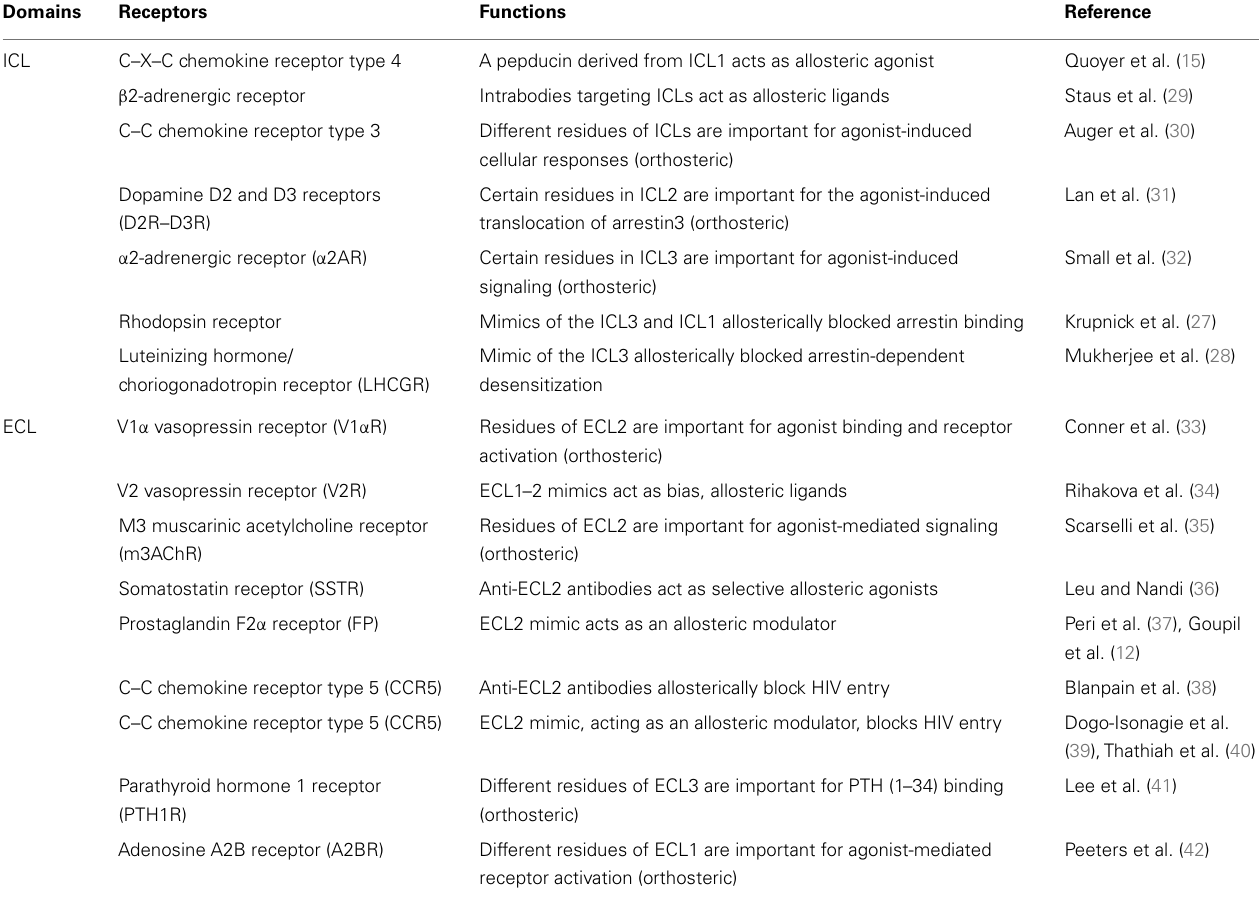
Table 1 | Role of GPCRs intracellular (ICL) and extracellular (ECL) domains in receptors function